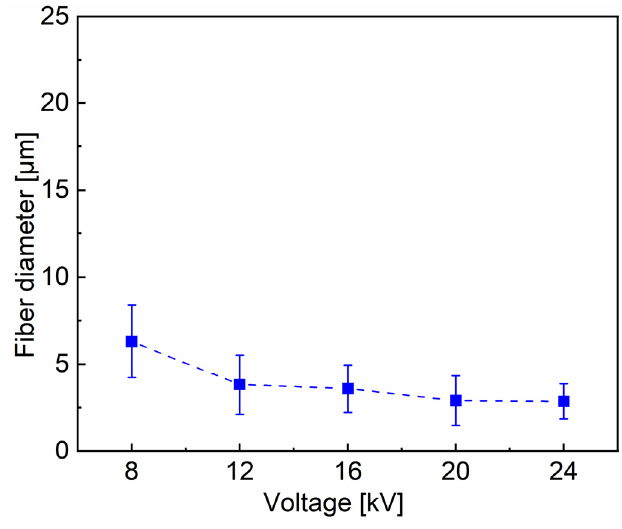
Figure 10. Tendency of average diameter of PVA fibers with applied voltage.